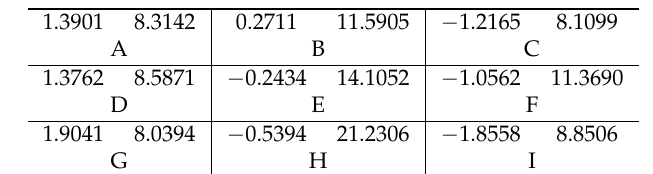
Table 2. Velocity components for dense initial packing density presented for nine zones, from A–I. Each quadrant presents horizontal (Vx on the left) and vertical (Vy on the right) components only. Vx and Vy values are given in mm/s.